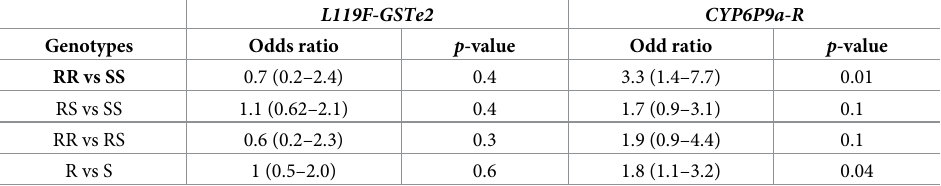
Table 2. Assessment of the association of L119F-GSTe2 and CYP6P9a-R mutations with An . funestus mosquito blood